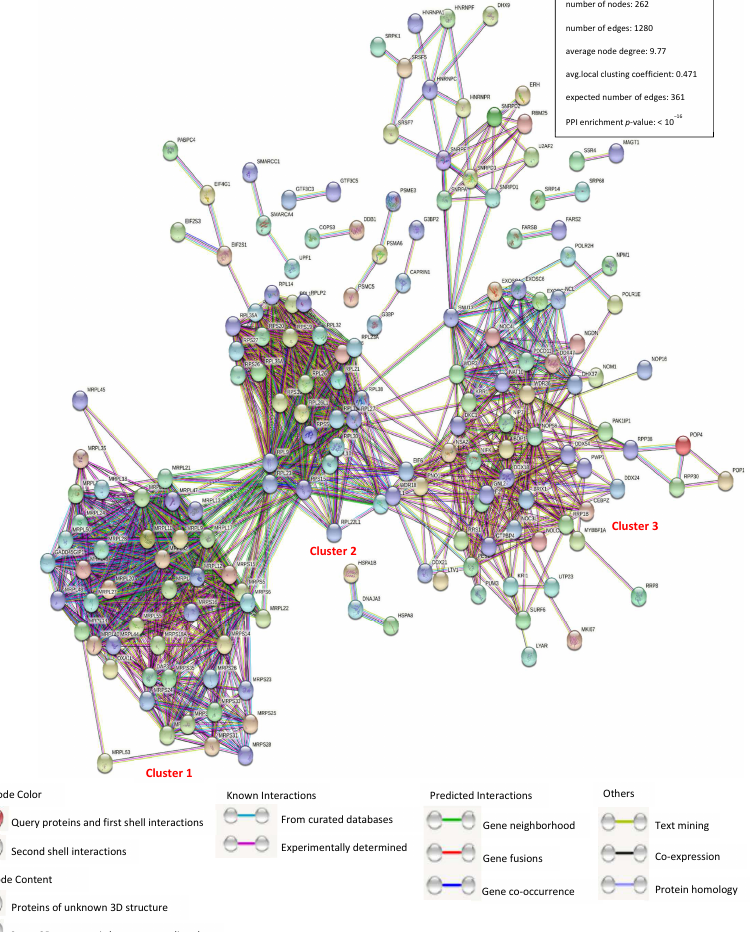
Figure 2. Construction and analysis of the protein-protein interaction network using the STRING database. Each edge color indicates a different method of protein–protein interaction prediction, as indicated below the figure. A map of the interaction of 278 identical bound host proteins shared amongst PCV3 and PCV4 Caps with the other proteins in our data was constructed and plotted using the network analyzer tool of the Cytoscape software, version 3.7.1. The corresponding symbols indicating the different protein classes are shown. Proteins are represented by their respective NCBI gene names (Supplementary Table